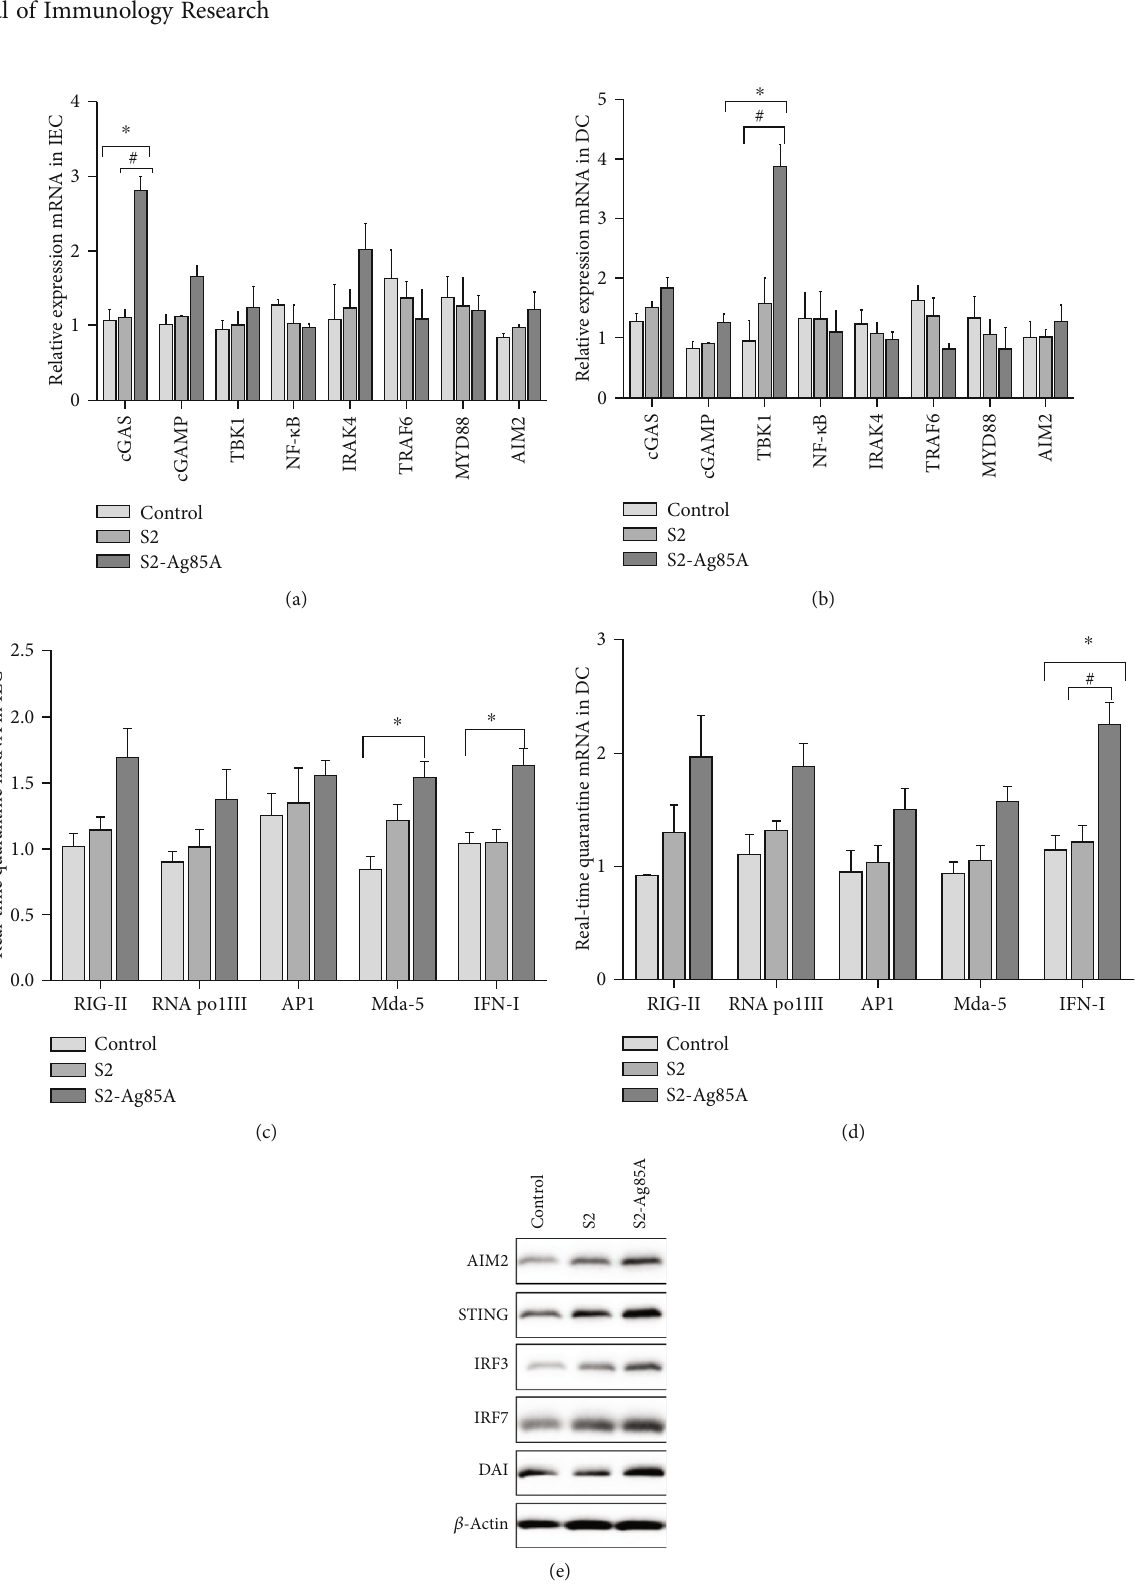
Figure 3: E ff ect of the S2-Ag85A vaccine on promoting dsDNA and RNA transmission pathways in IEC and DC cells. RT-PCR detection of (a) IEC cell sensor transduction molecules cGAS ( P < 0 : 05 ), cGAMP, TBK1, NF- κ B, IRAK4, TRAF6, MYD88, and AIM2; (b) DC cell sensor transduction molecules cGAS ( P < 0 : 05 ), cGAMP, TBK1 ( P < 0 : 05 ), NF- κ B, IRAK4, TRAF6, MYD88, and AIM2. Q-PCR for (c) IEC cell sensor molecules RIG-I, RNA Pol III, and AP1; (d) DC cell sensor molecules RIG-I, RNA Pol III, and AP1. (e) Western blot for AIM2, STING, IRF3, IRF7, and